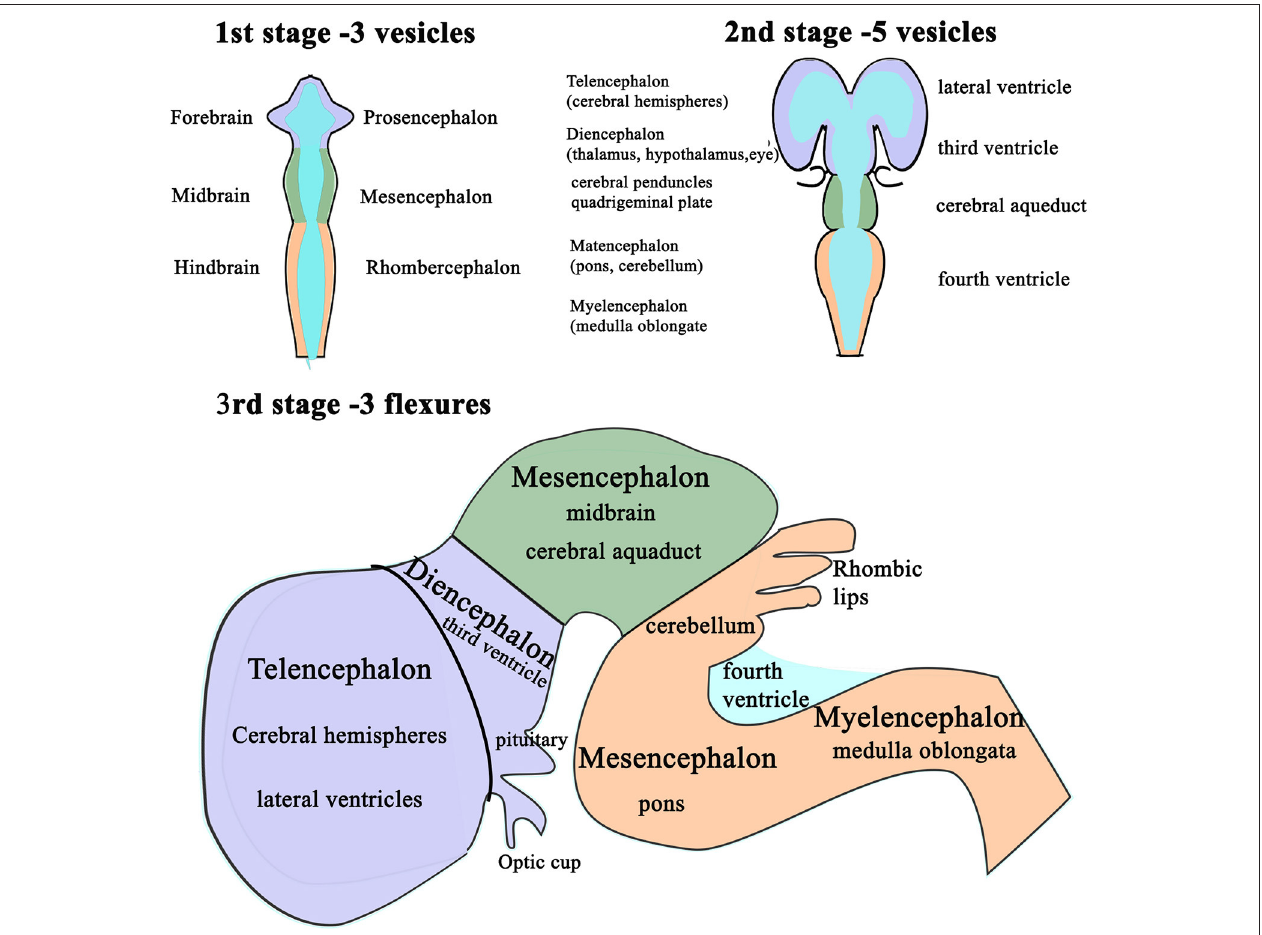
FIGURE 3 | Schematic diagram of the differentiation of vesicles in the developing brain. The three stages in the development of the vesicles within the brain as changes in differential growth and proportions of the forebrain, mid brain and hindbrain (1st and 2nd stages) are modified by flexures that still allow the continuity of the CSF channels within. Stage 3 illustrates the formation of cerebellum and its relationship with the fourth ventricle and the cerebral